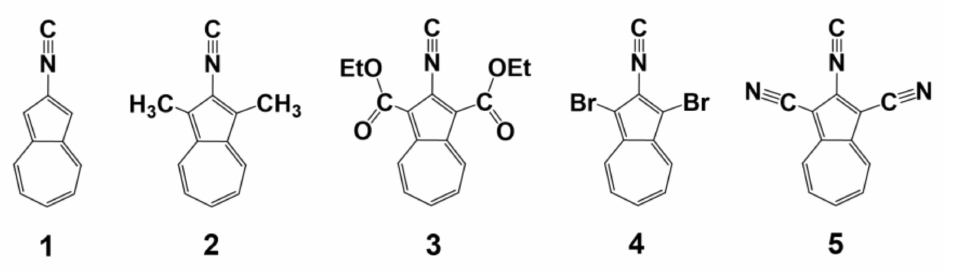
Figure 2. Five 2-isocyanoazulene ligands considered in this work: 2-isocyanoazulene ( 1 ), 2-isocyano- 1,3-dimethylazulene ( 2 ), 2-isocyano-1,3-diethoxycarbonylazulene ( 3 ), 2-isocyano-1,3-dibromoazulene ( 4 ), and 2-isocyano-1,3-dicyanoazulene ( 5 ). 2.